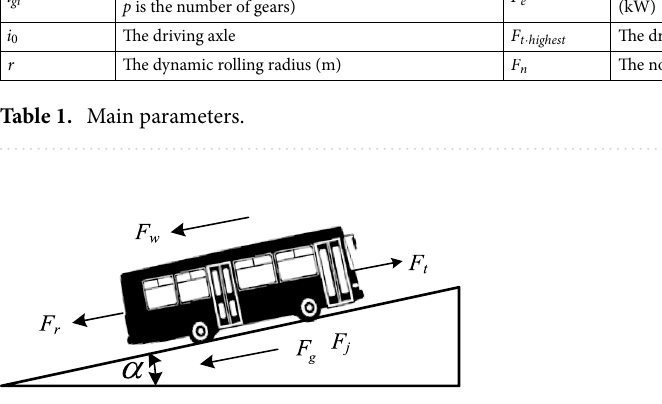
Figure 2. The forces that affect the vehicle during